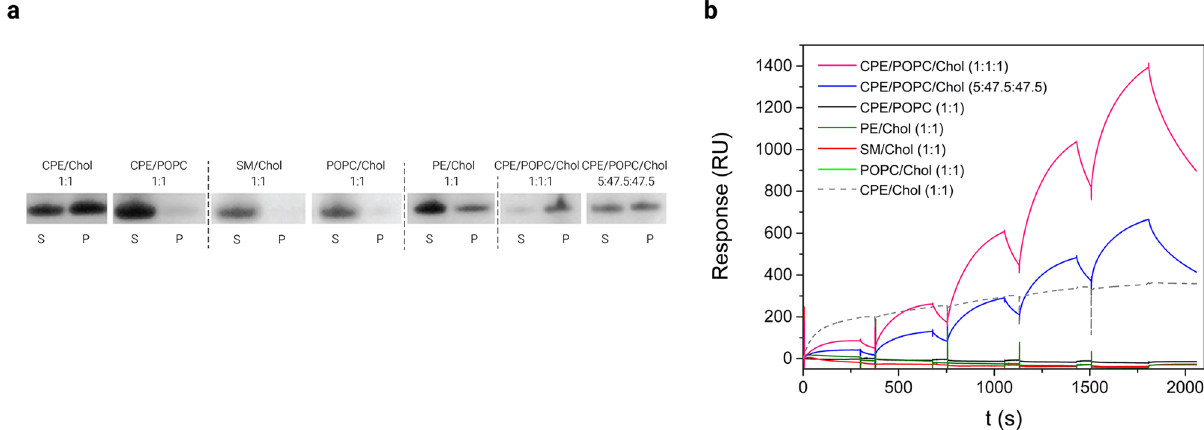
Figure 1. RahU selects for CPE in lipid membranes. ( a ) Binding of RahU protein to multilamellar vesicles with various lipid compositions, as indicated with mole-to-mole ratios. The liposome-RahU co-sedimentation experiments were performed in Hepes buffer pH 7.4. The supernatant (S) and pellet (P) fractions were subjected to SDS-PAGE analysis and stained with Coomassie Blue. The dotted vertical dividing lines indicate the cropped parts of the same gel image. The full-length gels are shown in Fig. S1. ( b ) Surface plasmon resonance analysis of RahU protein in 10 mM Hepes buffer binding to immobilized large unilamellar vesicles, composed of equimolar CPE/POPC, SM/cholesterol, POPC/cholesterol or PE/cholesterol, CPE/cholesterol, CPE/POPC/cholesterol, or 5:47.5:47.5 (mol:mol:mol) CPE/POPC/cholesterol by applying kinetic titration approach via consecutive injections of RahU in 0.5, 1, 2, 3 and 4 μM (from left to right) concentration. Vesicles were immobilized to Biacore L1 chip to 7000–11,000 RU, except for large unilamellar vesicles (LUVs) composed of equimolar CPE/ cholesterol, which were immobilized to 1400 RU due to their instability, and set as baseline 0 RU in order to show only the RahU-vesicle interaction (the sensorgram, showing RahU binding to CPE/cholesterol vesicles is shown as a dashed line to indicate that fewer vesicles were immobilized on the chip than for vesicles of other lipid composition). Representative sensorgrams from two independent experiments are shown. S supernatant, P pellet, CPE ceramide phosphorylethanolamine, Chol cholesterol, POPC 1-palmitoyl-2-oleoyl-sn-glycero-3- phosphocholine, SM sphingomyelin, PE